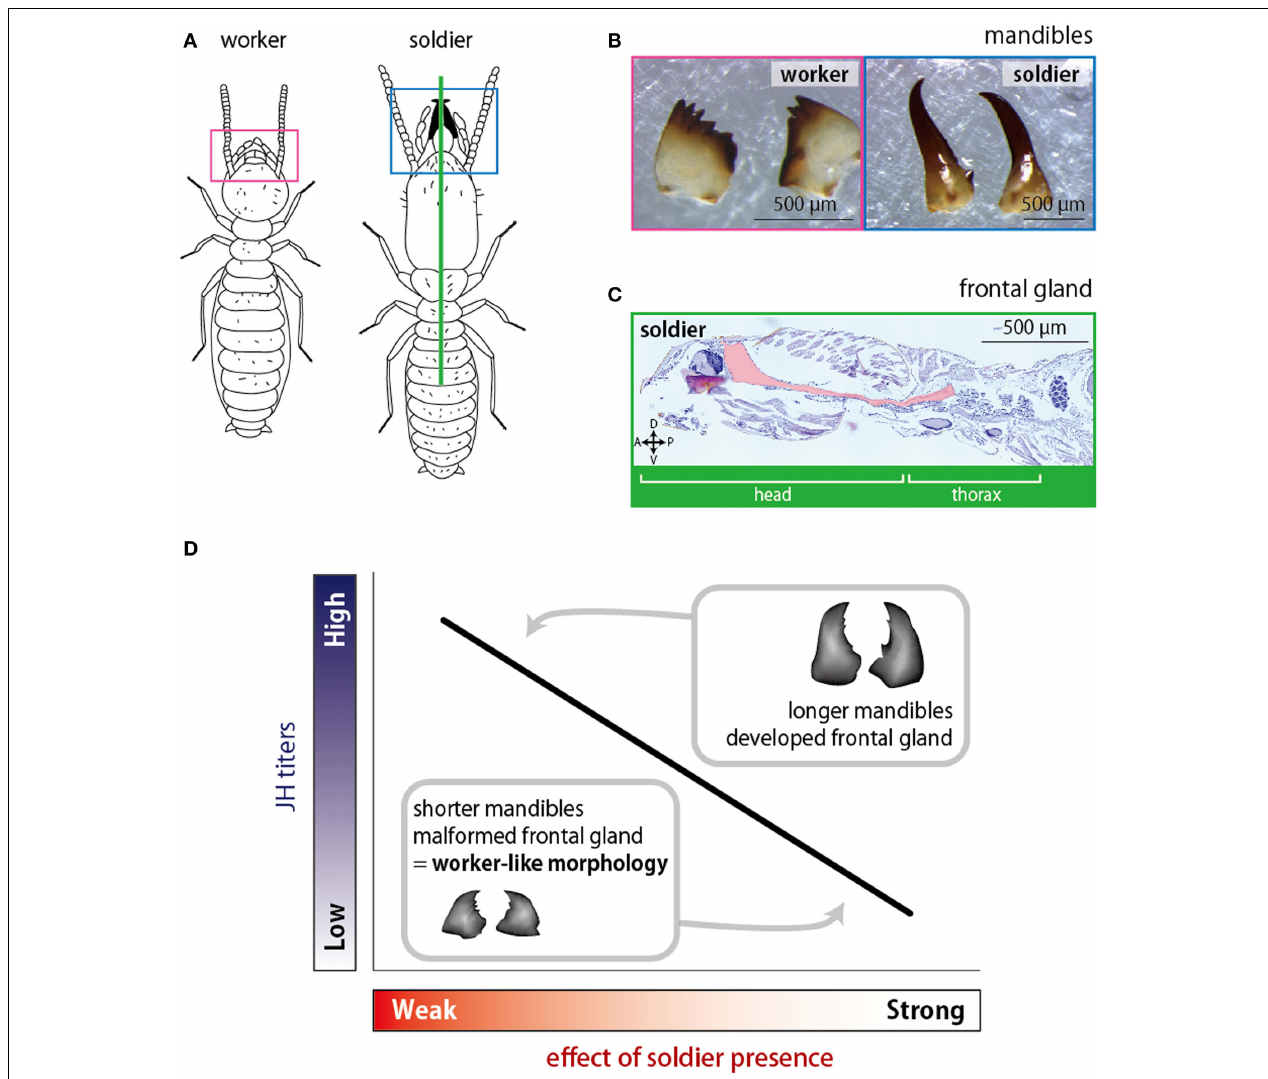
FIGURE 5 | ThesoldiereffectsonmorphogenesisshownbyTsuchiyaetal. (2008)andWatanabeandMaekawa(2012).(A) Illustrationsofasoldieranda workerof Reticulitermessperatus . (B) Mandiblesofaworker(left)andasoldier (right). (C) A Median section of a soldier. The frontal gland invaginates into the